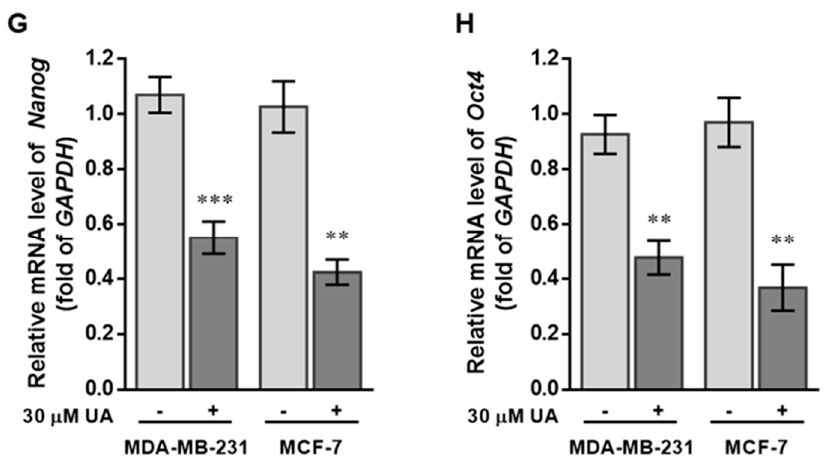
Figure 2. UA reduces the fraction of SP in breast cancer cell lines: ( A ) Representative examples of cancer stem cells (SP cells) were exploited by the flow-activated cell sorting (FACS) technique. Cells were stained with Hoechst 33342 dye in the absence (left) or presence (middle) of 50 µ M reserpine and 30 µ M UA (right) was evaluated by FACS. The uptake of Hoechst 33342 dye occurs uniformly in all cells through passive diffusion (shown in red), SP was detected by the loss of the fluorescent population (shown in green) after treatment with the ABCG2 inhibitor (RES) or UA. ( B ) The relative percentage of SP was estimated in human MDA-MB-231 and MCF-7 cell lines stained with Hoechst 33342 after incubation with UA for 48 h. ( C ) Western blot image and ( D ) reverse transcription-PCR (RT-PCR) data indicate that AGO2 levels in MDA-MB-231 and MCF-7 cell lines were significantly reduced after treatment with UA relative to control cells. ( E ) Reduced ABCG2 associated with lower levels of CSC-related genes encoding ( F ) CD133 , ( G ) Nanog , and ( H ) Oct4 in breast cancer cell line after UA treatment compared with the same cell line without UA treatment. GAPDH was used as an internal control for the detection of mRNA transcripts. Data were presented as mean ± SD from three independent experiments. * p < 0.05; ** p < 0.01; *** p < 0.001 vs. the untreated control.